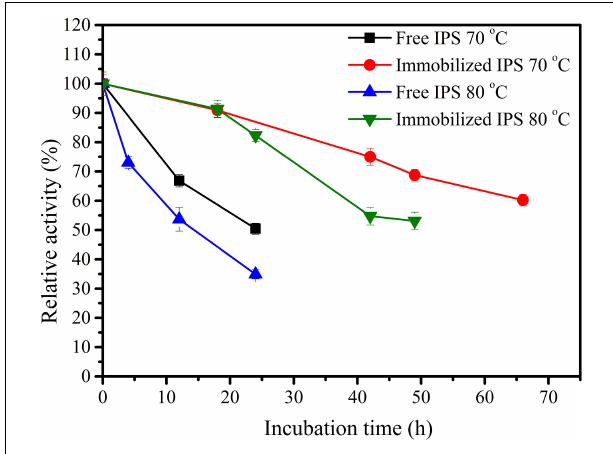
FIGURE 2 | Themostability of free and immobilized IPS at 70 ◦ C and 80 ◦ C.